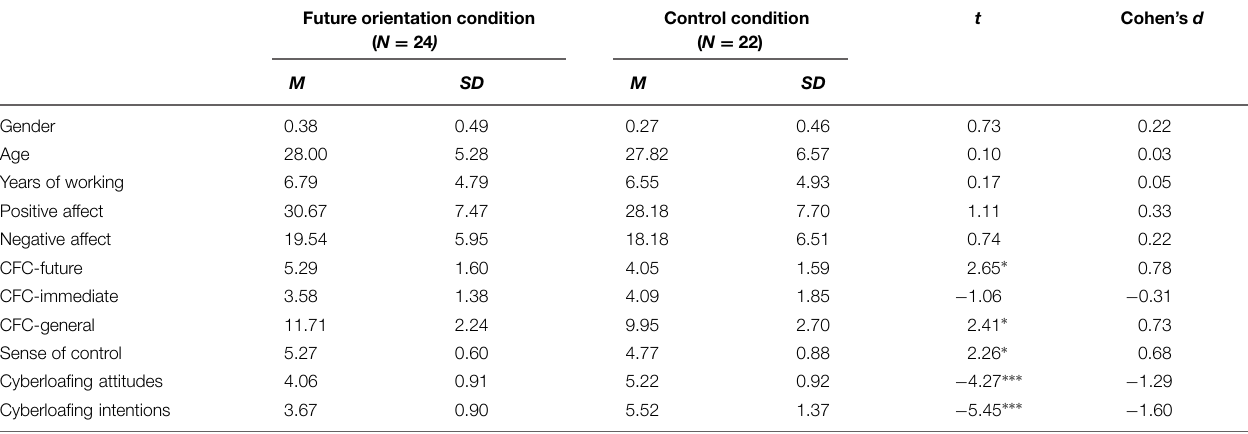
TABLE 3 | A t -test analysis of the future orientation condition and the control condition.